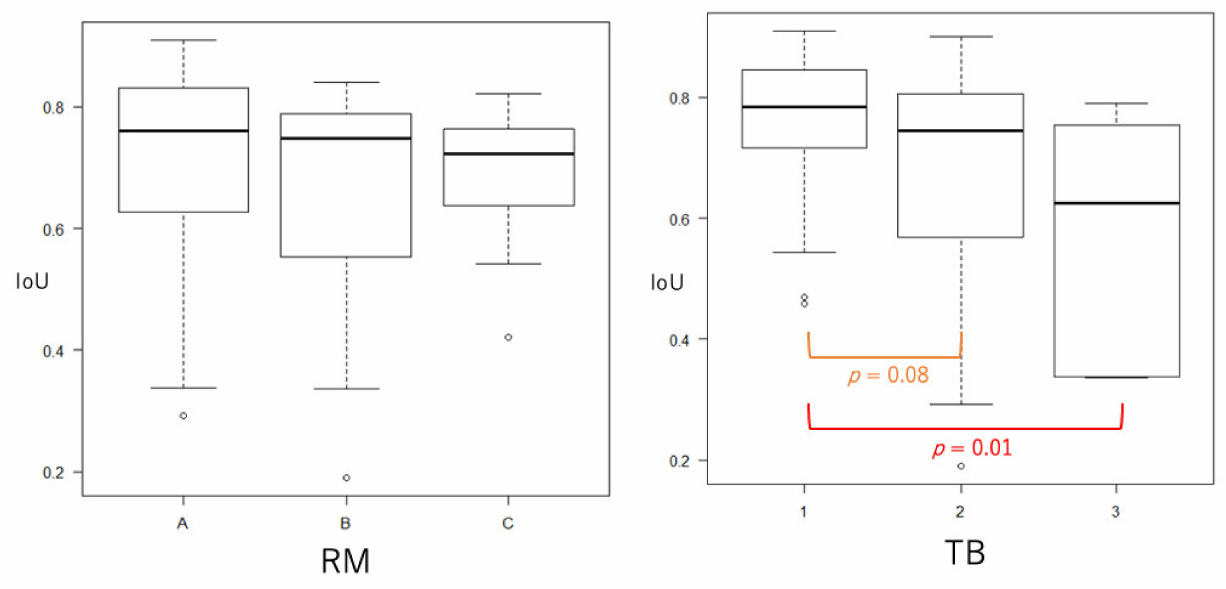
Figure 6. Intersection over Unit by the classification of respiratory movement and tumor boundary. No significant difference was seen in the intersection over unit (IoU) between the groups of RM; however, IoU in TB-1 was significantly higher than that in